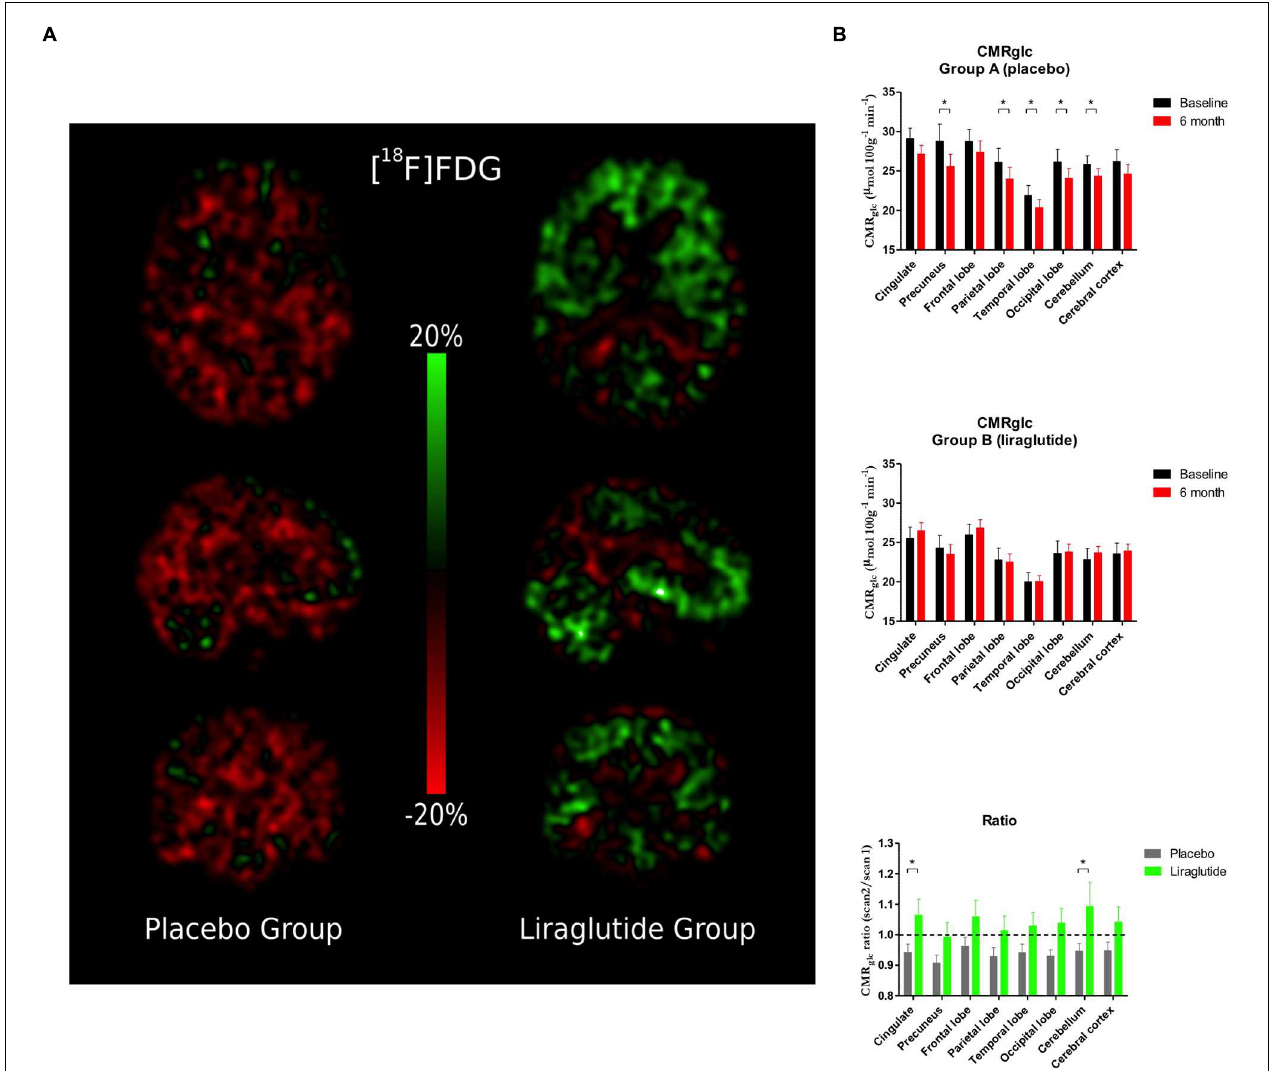
FIGURE 2 | (A) Percentage change in cerebral metabolic rate for glucose (CMR glc ) between baseline scan and 6-month follow-up. (B) Cerebral metabolic rate for glucose uptake (CMR glc ) in the cingulate cortex, precuneus, frontal, parietal, temporal, and occipital lobes, cerebellum, and cerebral cortex at baseline and the Ratio Session 2/1 in the placebo group and the liraglutide group. ∗ P <